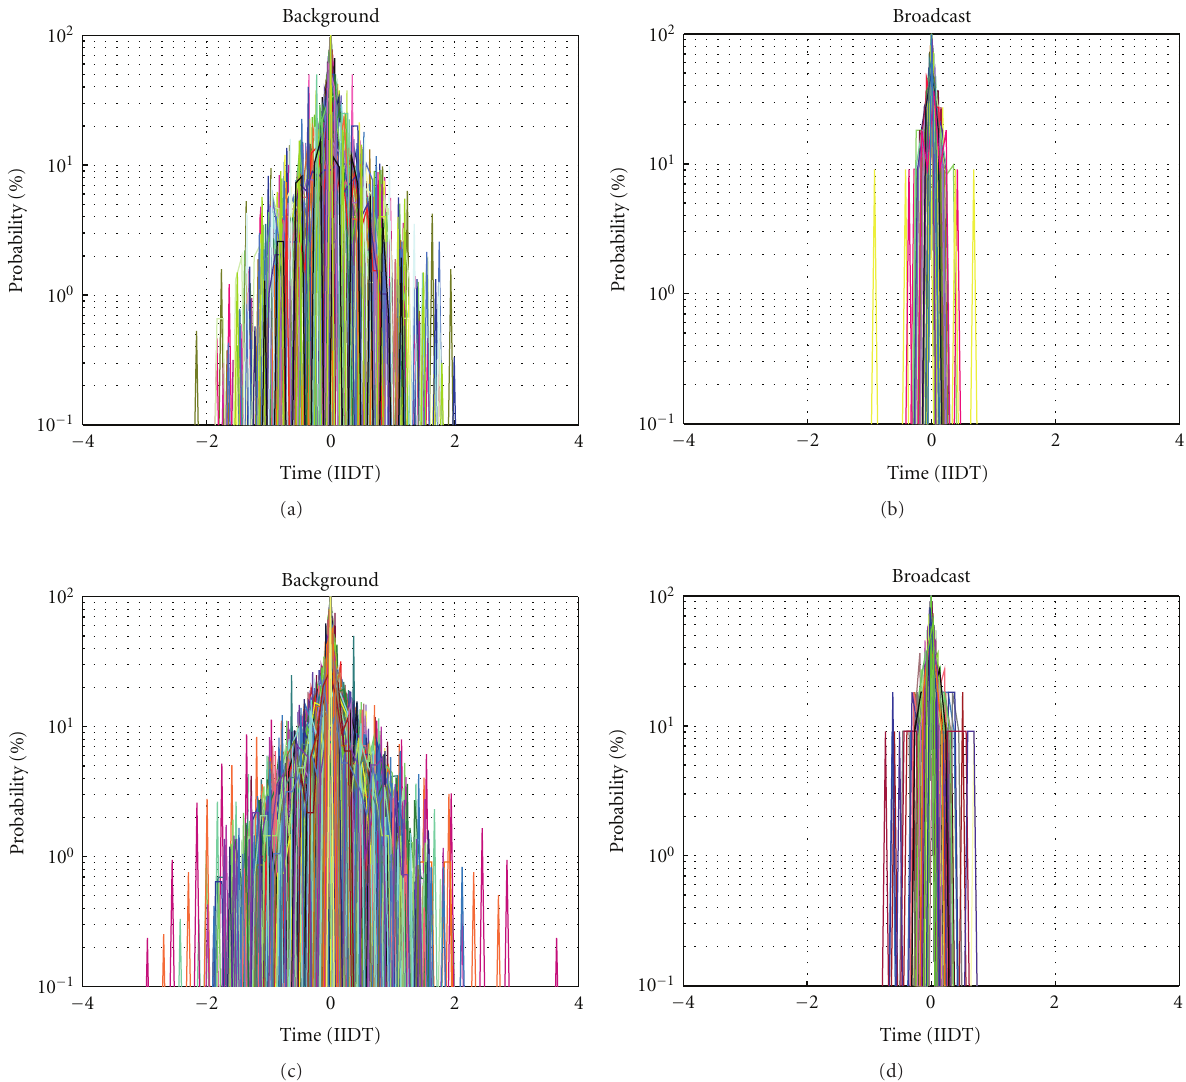
Figure 8: PDF of Delay Jitter. (a) and (b): Nobel-EU topology. (c) and (d): Germany50